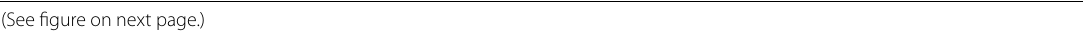
Fig. 9 a Synthesis of pB-DOX. b Schematic illustration of Lipo/pB-DOX/ICG combined photodynamic therapy with ROS-responsive chemotherapy to synergistically treat cancer cells (Panel A ). The ICG-generated ROS would exert photodynamic therapy by inducing cell necrosis or apoptosis